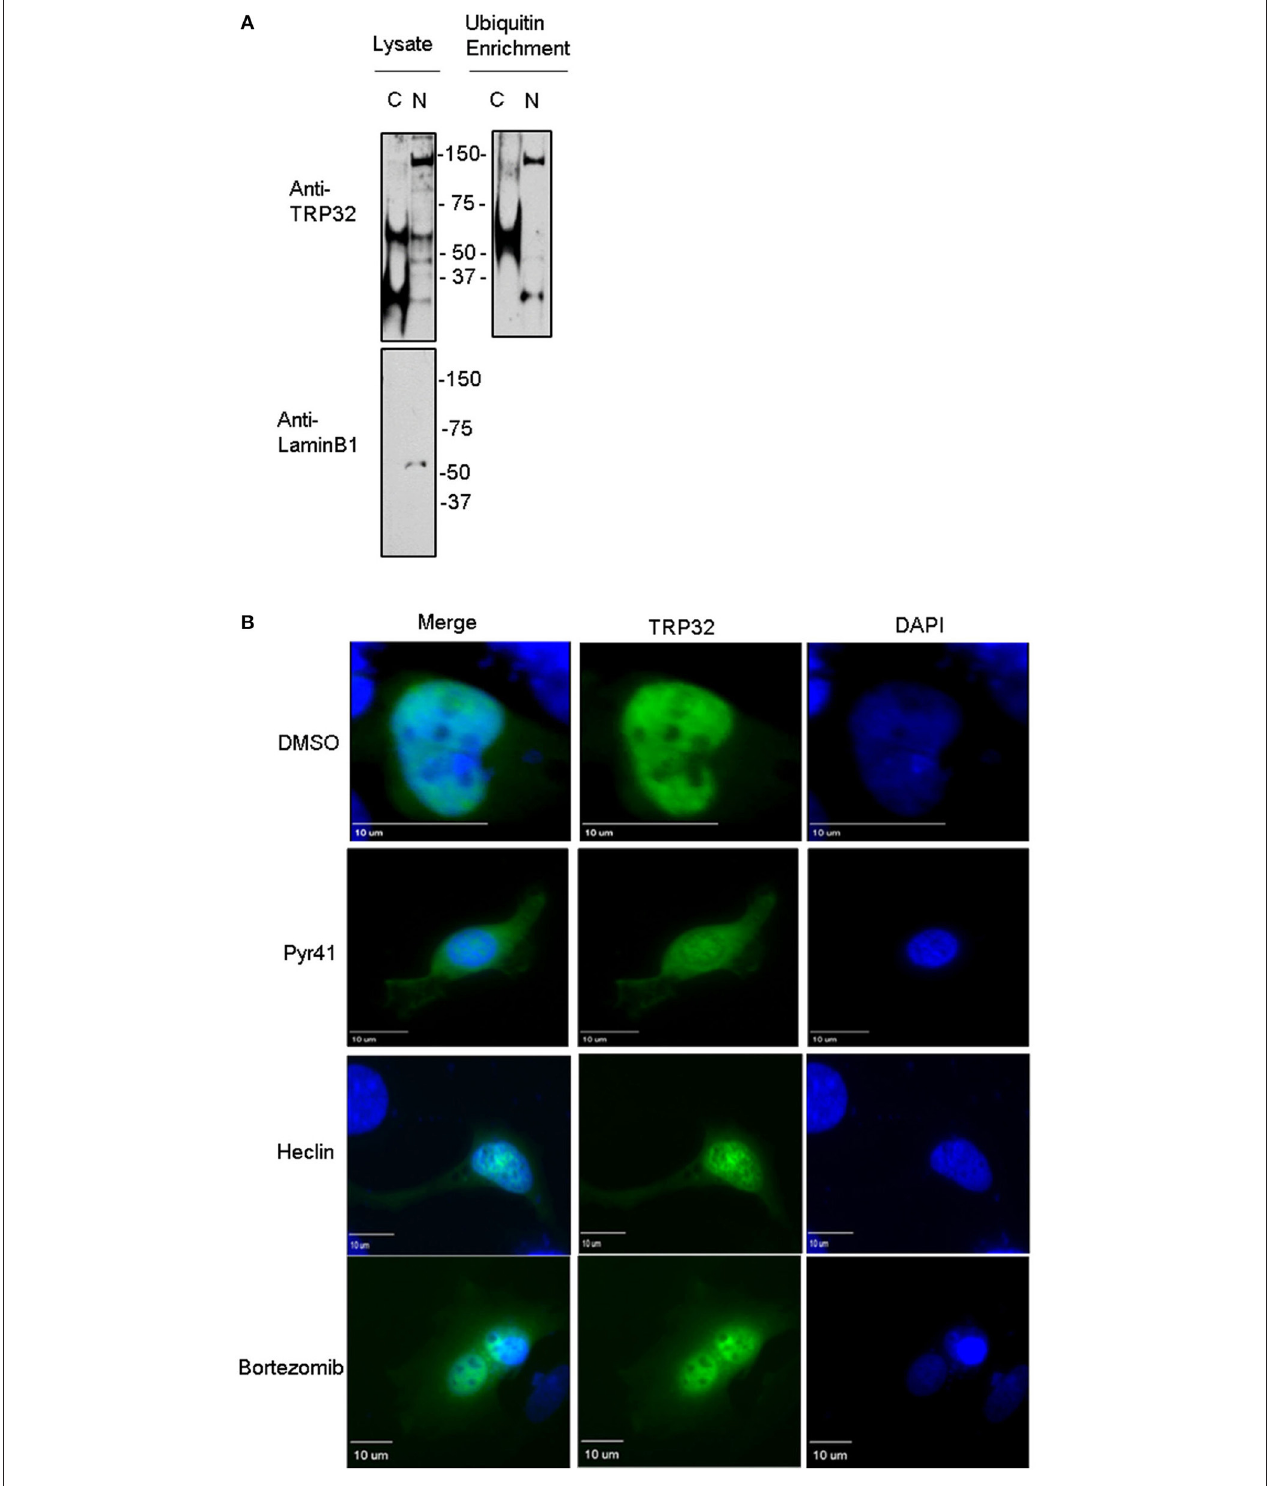
FIGURE 4 | Ubiquitination inhibitors cause altered subcellular localization of GFP-tagged TRP32. (A) Polyubiquitinated TRP32 is detected in both the nucleus and cytosol of infected cells. E. chaffeensis -infected THP-1 cells were harvested and subject to nuclear cytosolic fractionation before Ub enrichment. Lysate and eluate from Ub enrichment were probed with anti-TRP32 specific antibody by immunoblot. (B) HeLa cells were transfected with GFP-tagged TRP32. After 6h the medium was changed and Pyr41 (50 µ M), heclin (25 µ M), bortezomib (100nM) or DMSO (vehicle) were added. At 24h post-transfection cells were fixed and visualized using fluorescent microscopy. Nuclei are stained blue